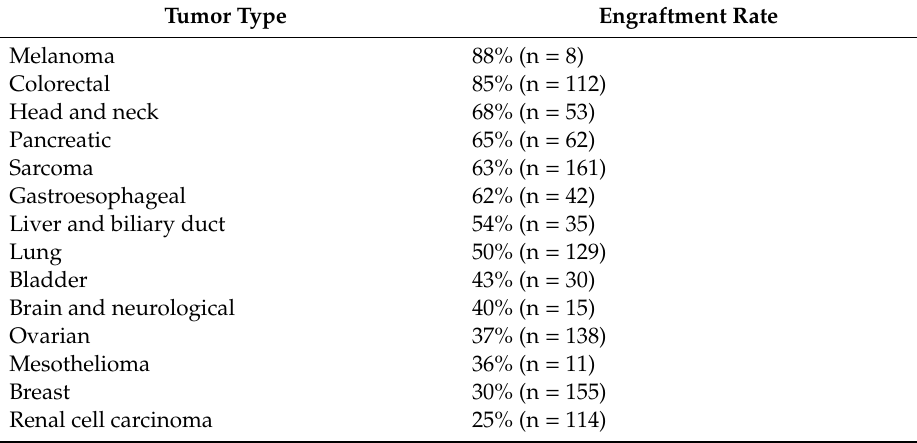
Table 2. Comparison of patient-derived xenograft graft survival rates based on the primary lesion site. Tumor